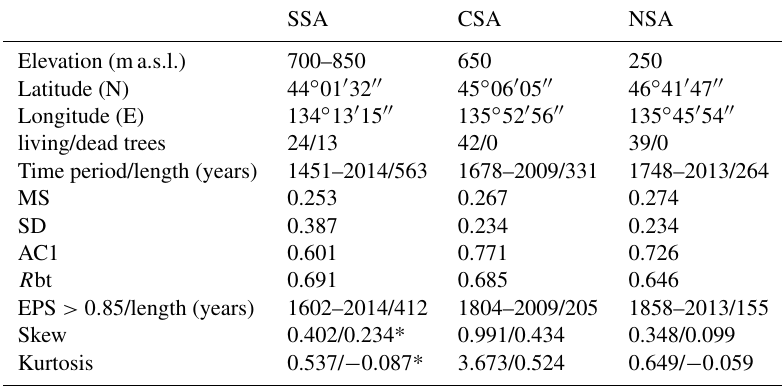
Table 1. The sampling information and descriptive statistics of the residual chronologies. MS: mean sensitivity; SD: standard deviation; AC1: first-order autocorrelation; EPS: expressed population signal.